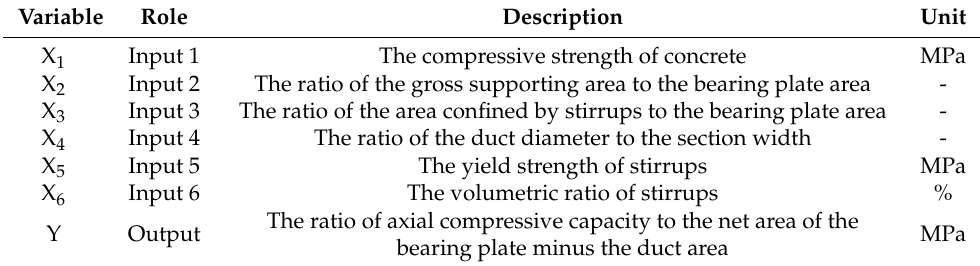
Table 1. Definition of the variables in this research.